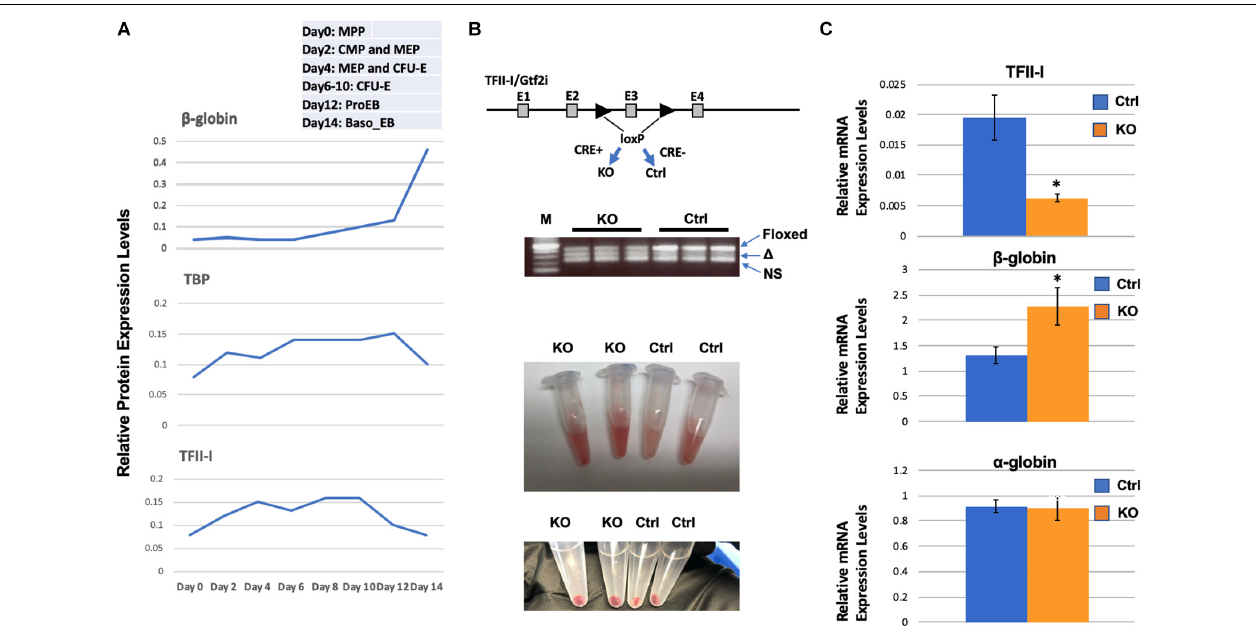
FIGURE 1 | Enhanced β -globin gene expression in TFII-I/Gtf2i deficient mice. (A) Relative protein expression levels for TFII-I, β -globin, and TBP during differentiation of erythroid cells. Data were extracted from a proteomic study by Gillespie et al. (2020). MPP, multiple progenitor population; CMP, common myeloid progenitors; MEP, myeloid erythroid progenitors; CFU-E, colony forming unite-erythroid; ProEB, proerythroblast; Baso EB, basophilic erythroblast. (B) Gtf2i floxed mice were mated with mice expressing Cre-recombinase in a tamoxifen inducible manner. PCR bands from three KO and three control mice represent the floxed Gtf2i gene (Floxed, 410 bp), the exon 3 deleted TFII-I gene ( (cid:49) , 328 bp), and a non-specific band (NS); lane M shows 500, 400, 300, 200, and 100 bp DNA fragments from top to bottom. Shown below are bone marrow cells and cell pellets from knock-out (KO) or control (Ctrl) mice. (C) RT-qPCR analysis of TFII-I, β -globin, and α -globin expression in bone marrow cells from KO and control mice (C1). Error bars are derived from two experimental replicates and three technical (qPCR) replicates (* p < 0.05).